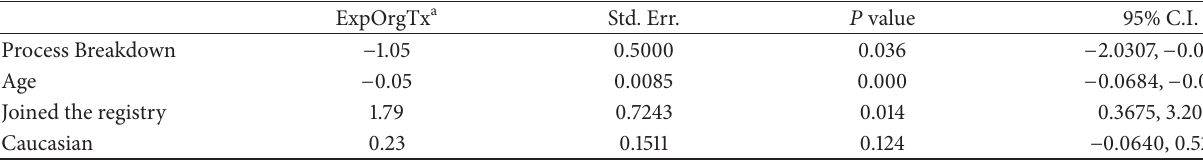
Table 6: Incremental and marginal effects.